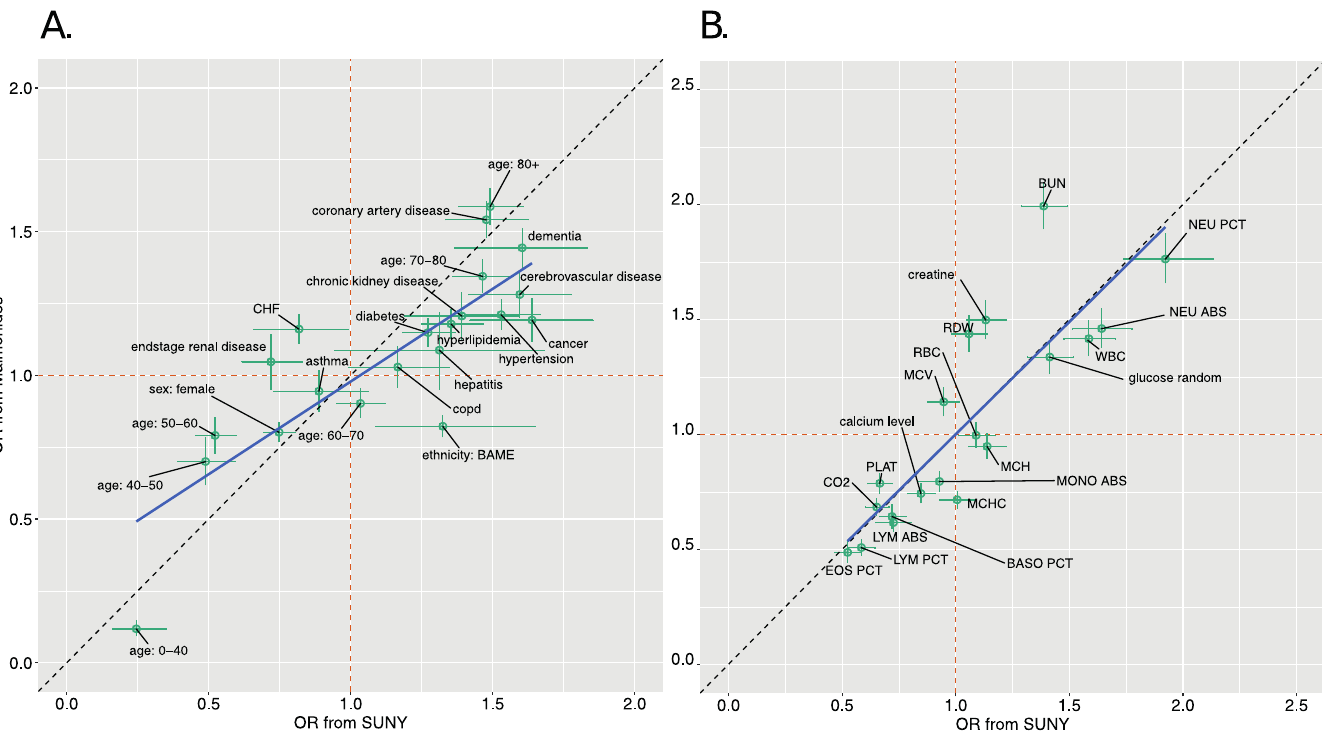
Fig 2. Comparing univariate mortality ORs across the hospitals. The two panels compare ORs associated with demographic and disease history variables (panel A) and initial laboratory test values (panel B). Points show the posterior median ORs; the whiskers display the 25% and 75% posterior quantiles. The orange dashed lines show the OR = 1 cases; the dashed black lines indicate equality in the ORs across the two hospitals. The blue line shows least squares regression lines using the posterior median ORs.